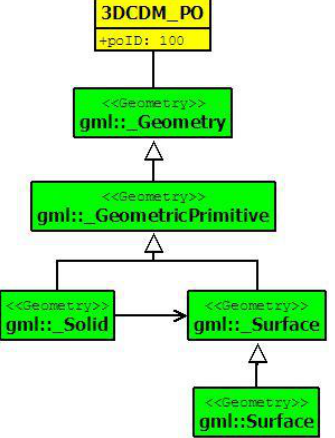
Figure 19. Instance of 3DCDM_Geometry Package